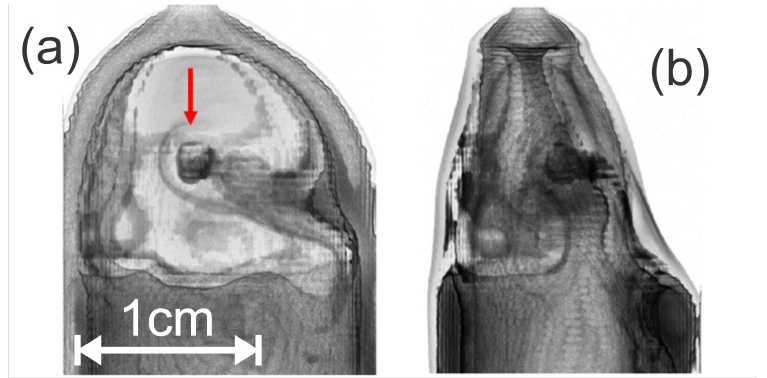
Figure 11. 3D reconstruction of the Dominican amber sample based on transmission amplitude with optimized luminance, allowing for internal structure observation. ( a ) Front profile with red arrow indicating termite head location. ( b ) Side profile. An animated GIF file of the 3D reconstructed image is included as a Supplementary Materials Video S1.